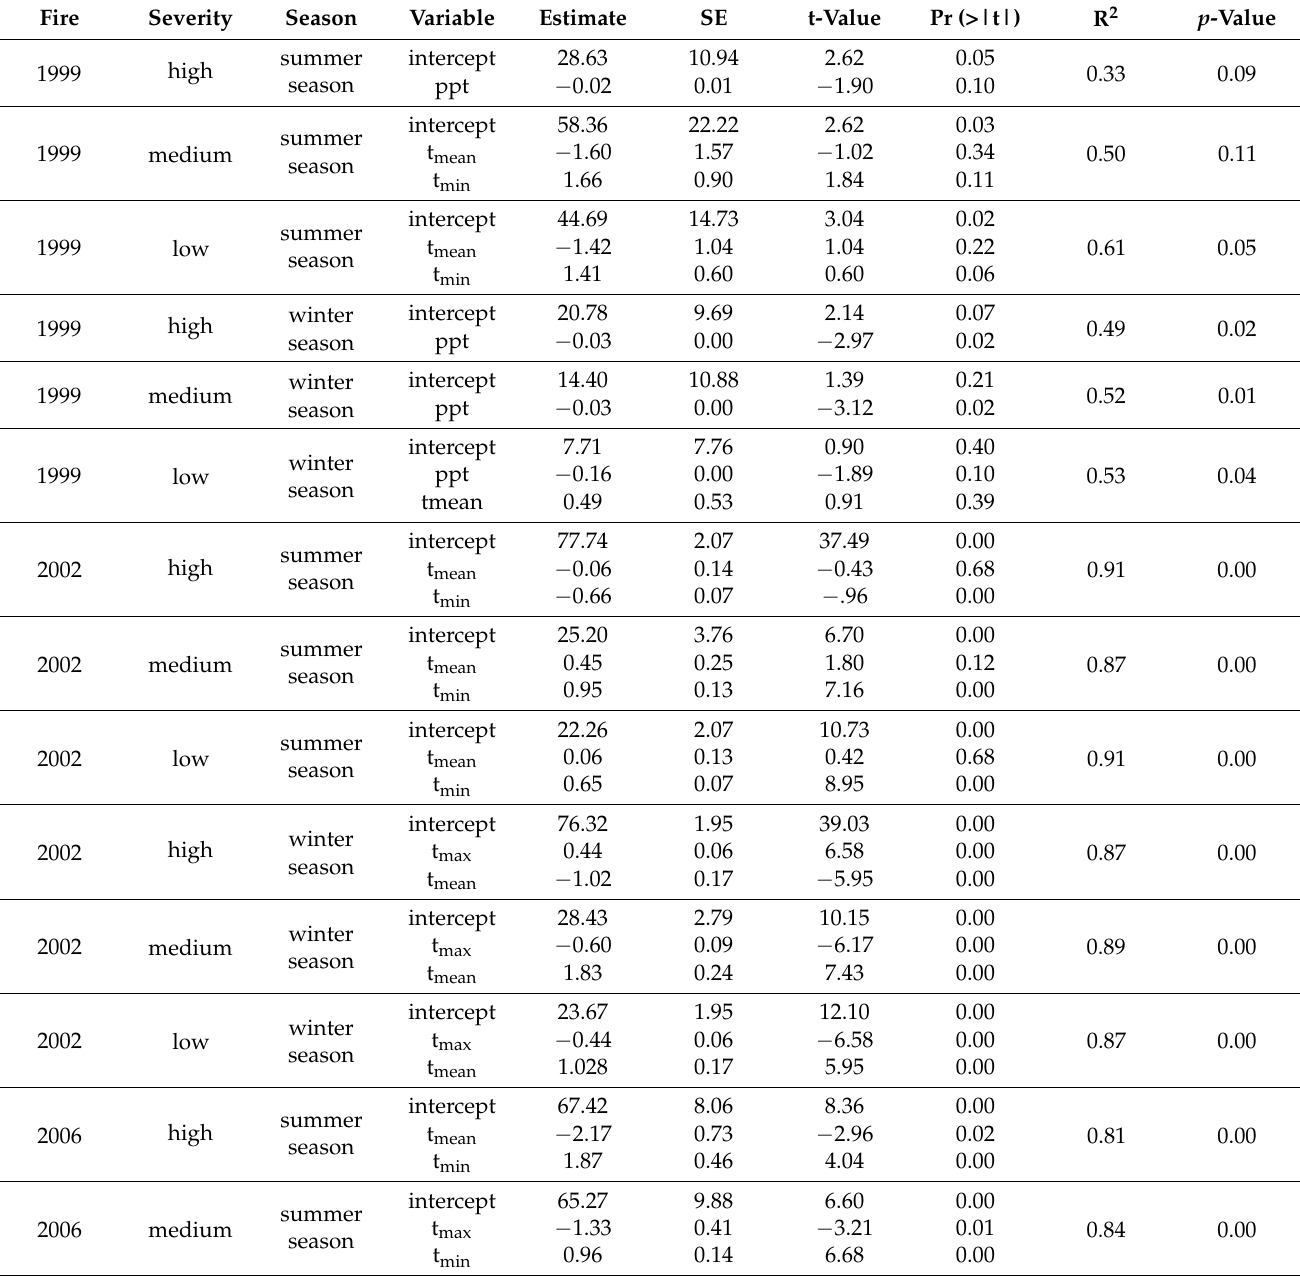
Table 5. Regression parameters from the backward stepwise regression conducted between the %NBR change and climate